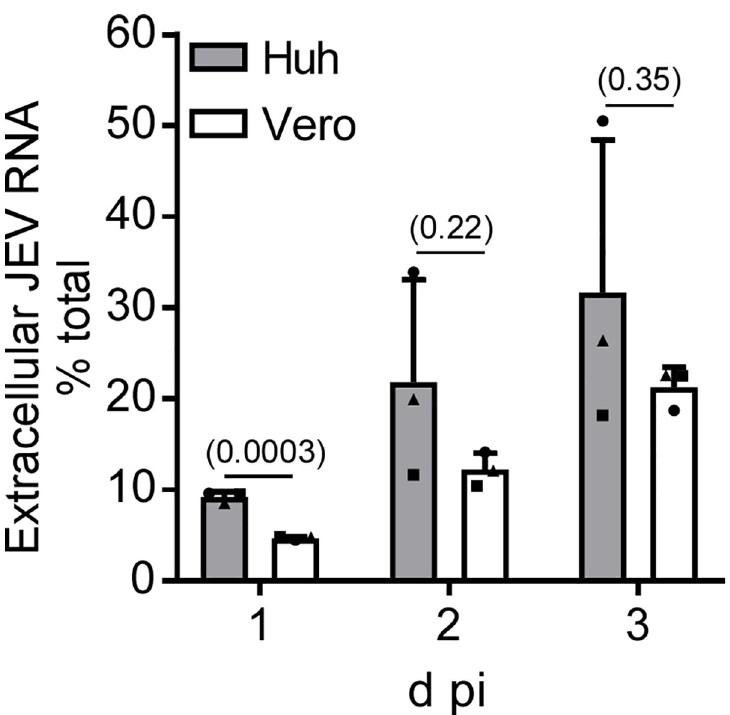
Fig 6. Huh7.5.1–8 cells released JEV more efficiently than Vero cells early in infection. Cells were infected with JEV at MOI 0.1 under high confluency conditions as described in the legend to Fig 2. Cells and culture supernatant were harvested at the indicated times. RNA was extracted and purified, and the viral RNA copy number in each RNA fraction was determined by qRT-PCR. The extracellular amount of viral RNA was expressed as a percentage of the total (extracellular plus intracellular) amount of viral RNA. Data represent the mean ± SD of three independent experiments. Each symbol represents the mean from one experiment. Statistical significance was determined by an unpaired two-tailed t test. Values in parentheses indicate p values, and those less than 0.05 were considered statistically